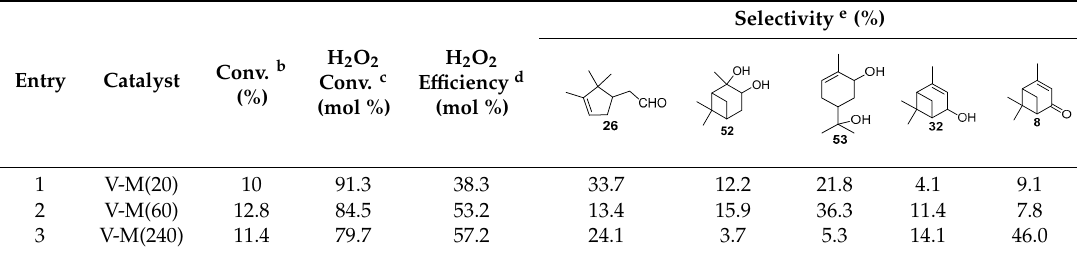
Table 25. Oxidation of α -pinene 1 over V-M(x) catalysts. Influence of the metal content a (adapted from reference [83]).